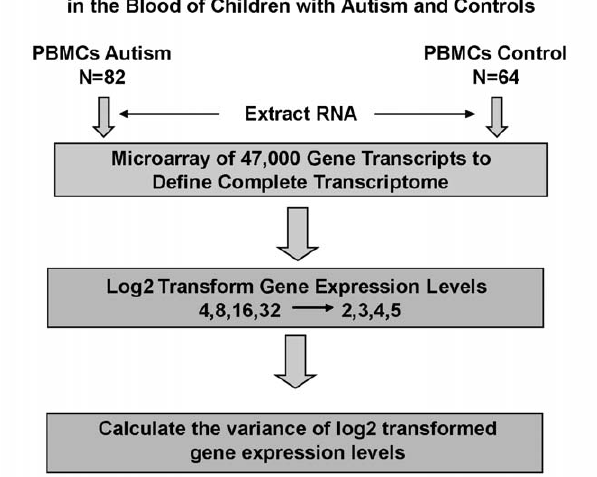
Figure 1. Schematic for determining the large-scale organiza- tion of gene expression in the blood of children with autism and controls. The figure displays the steps used to evaluate the large- scale organization of gene expression in the blood of children with autism and controls. Peripheral blood lymphocytes were purified from the blood of children with autism (n=82) or control subjects (n=64). Total RNA was extracted for microarray experiments with Affymetrix Human U133 Plus 2.0 3 9 Expression Arrays. Array data was pre- processed and summarized using Affymetrix Microarray Analysis Suite 5.0 (MAS 5.0) to obtain 54,675 expression levels for approximately 47,000 unique transcripts including approximately 38,500 human genes. Expression levels were log2 transformed and the variance of log2 transformed expression levels was determined.